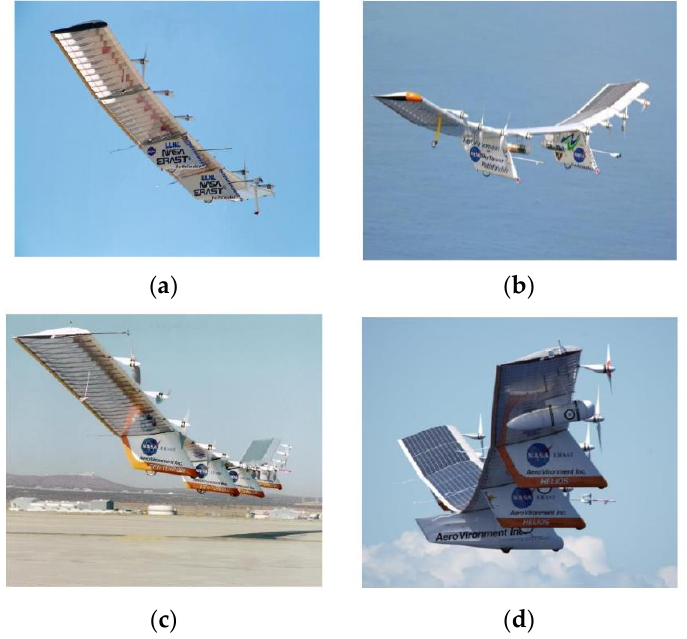
Figure 14. NASA ′ s fourth-generation solar-powered drone: ( a ) Pathfinder drone; ( b ) Pathfinder Plus drone; ( c ) Centurion solar-powered drone; ( d ) Helios drone.